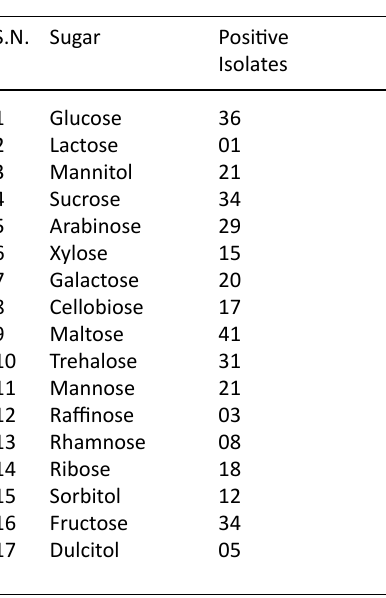
table 2. Utilization of Carbohydrates by isolates table 3. Enzymatic